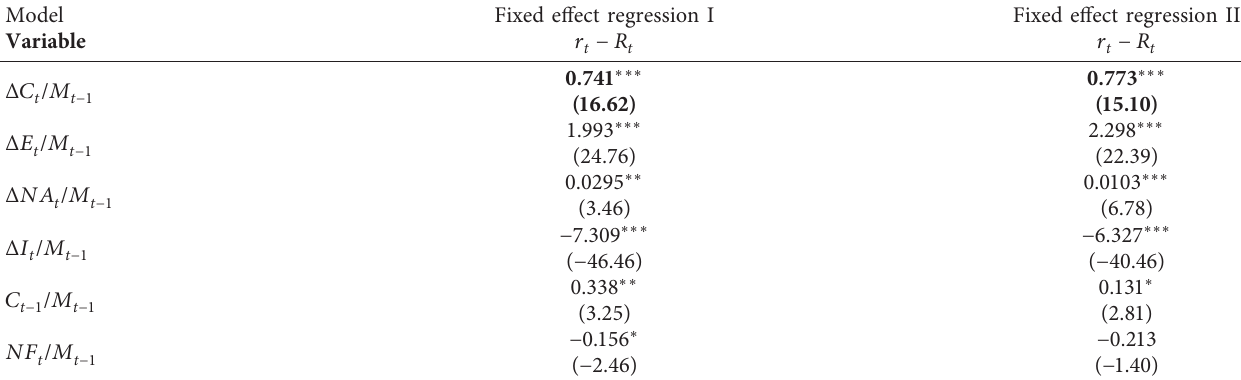
Table 5: The regression result of validating Hypothesis